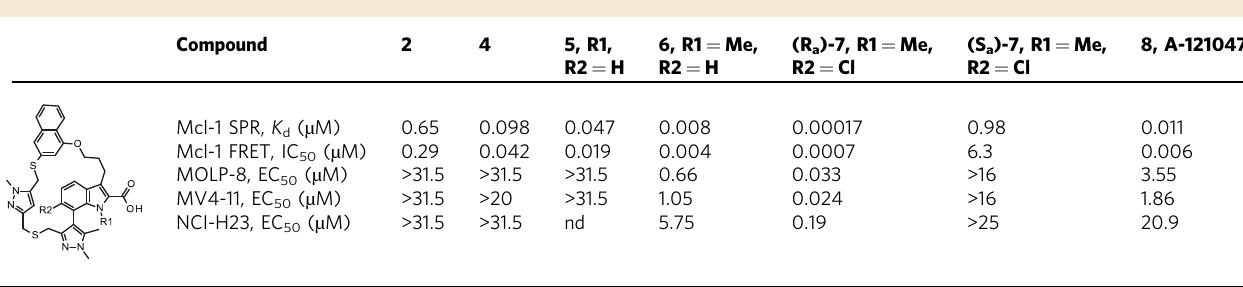
Table 1 In vitro activity of Mcl-1